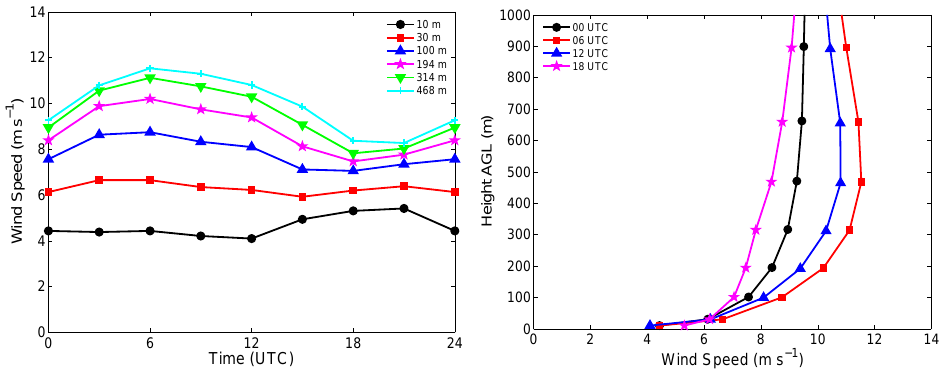
Figure 1. The WRF model forecast-derived one-year (April 2006–March 2007) average diurnal wind speed variation at Sumner, KS. Left panel: diurnal cycle at different heights in the atmospheric boundary layer. Right panel: vertical profiles at specific times of the